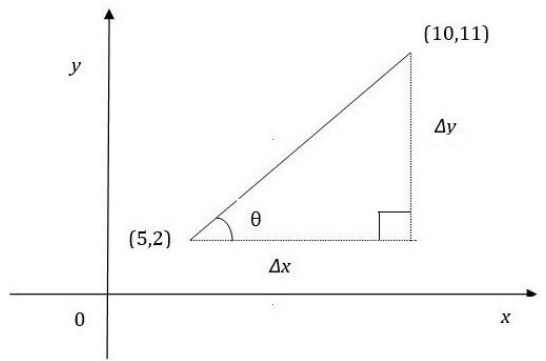
Figure 1. Construction of a right angled triangle using ∆ x